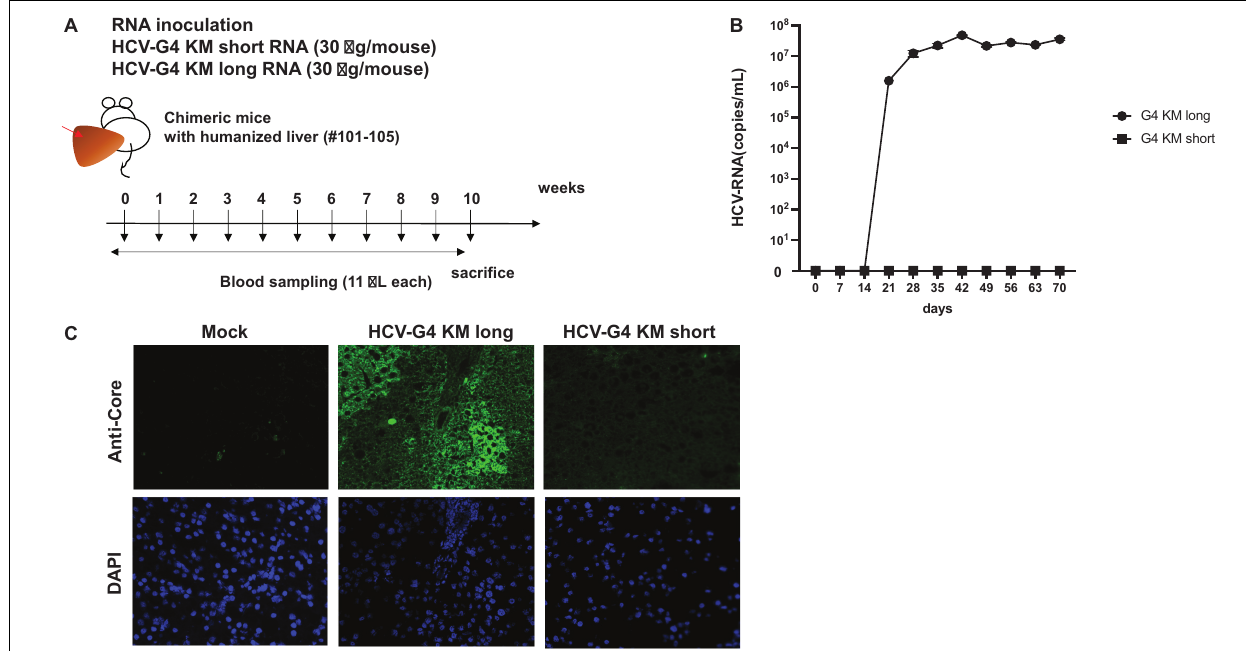
FIGURE 6 | HCV-G4 KM short or HCV-G4 KM long infection in humanized chimeric mouse. (A) Purified HCV-G4 KM short or HCV-G4 KM long RNA (30 µ g/mouse) was intrahepatically injected into humanized livers of chimeric mice (male, 20-weeks-old), which were bled every week until 10 weeks. (B) HCV RNA average amounts (copies/mL) in chimeric mouse sera ( n = 2) were monitored in triplicate samples by qRT-PCR. Vertical bars indicate the SD. (C) Staining of mock-infected (PXB288-032), HCV-G4KM long-infected (PXB201) or HCV-G4 KM short infected (G4KMN1-101) chimeric mouse liver tissue ( × 200) with anti-core antibody (RR8). Representative data of triplicate samples are